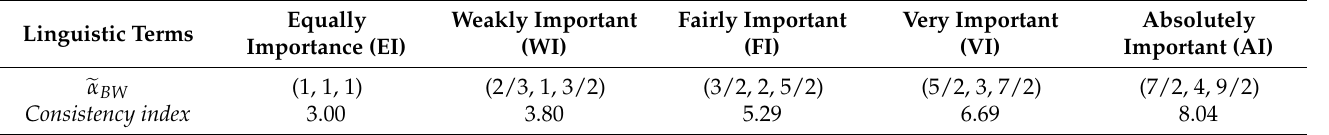
Table 5. Consistency index for